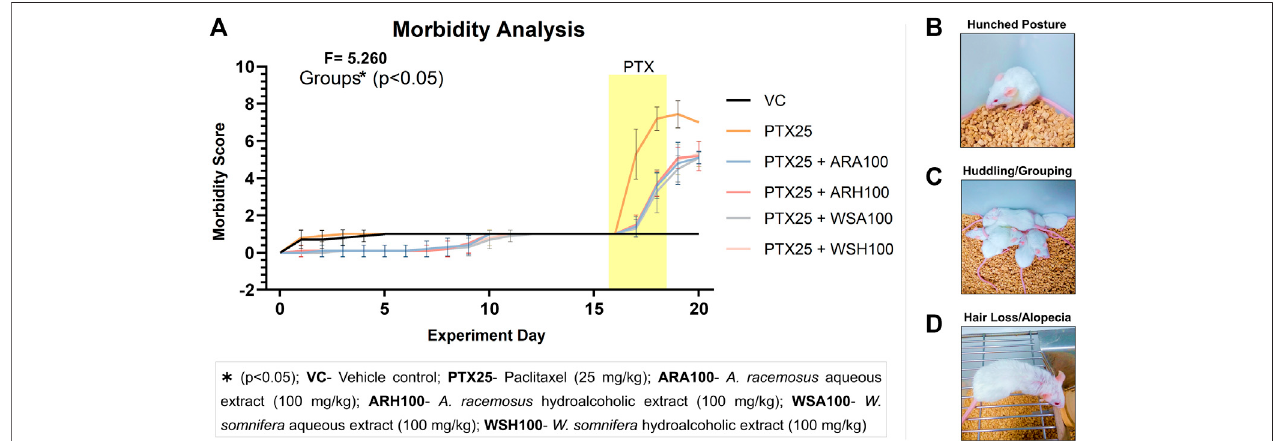
FIGURE 3 | Morbidity analysis. The fi gure represents that ARA, ARH, WSA, and WSH signi fi cantly prevented PTX-induced morbidity. (A) shows the graphical representation ofmorbidityscorebased onobservations ofmice.Theseobservations included reducedactivity and relocation, hunched posture (B) ,huddling/grouping (C) ,hairloss/alopecia (D) thatsimulatedclinicaladverseeffectsofPTX.Themorbidityscoreofeachgroupwascalculatedastheaverageofthesumofalltheparameters of each mouse of the group. Therefore, more the score more would be the morbidity signs in mice. The yellow patch depicts the duration of PTX dosing on 16th, 17th,and18thdayoftheexperiment.ThegraphshowsthatconsecutivedosingofPTX(25 mg/kg)increasesmorbidityscoreinmicefrom16thdayupto20thdayofthe experiment. Pre-administration of botanical extracts ARA, ARH, WSA, and WSH at 100 mg/kg dose 15 days prior to PTX dosing signi fi cantly ( p < 0.05) restricts the increased morbidity score. The data points are represented as mean ± SD with n =